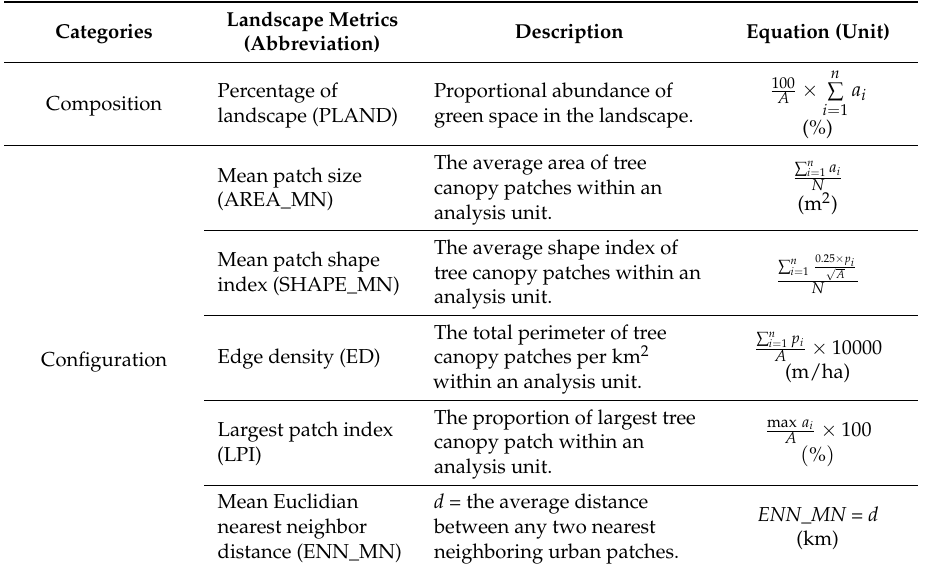
Table 1. Landscape metrics used in this